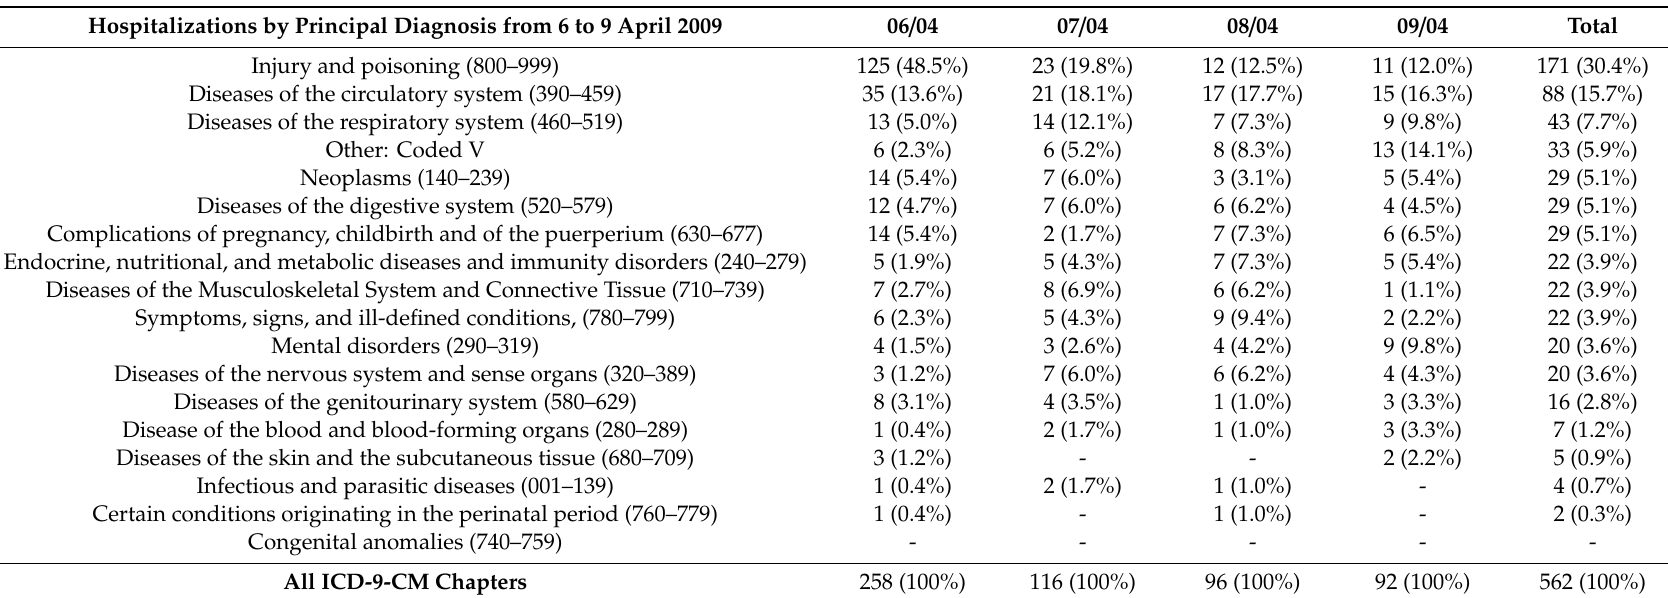
Table 1. All-cause hospital admissions among patients from the seismic crater area (ICD-9-CM